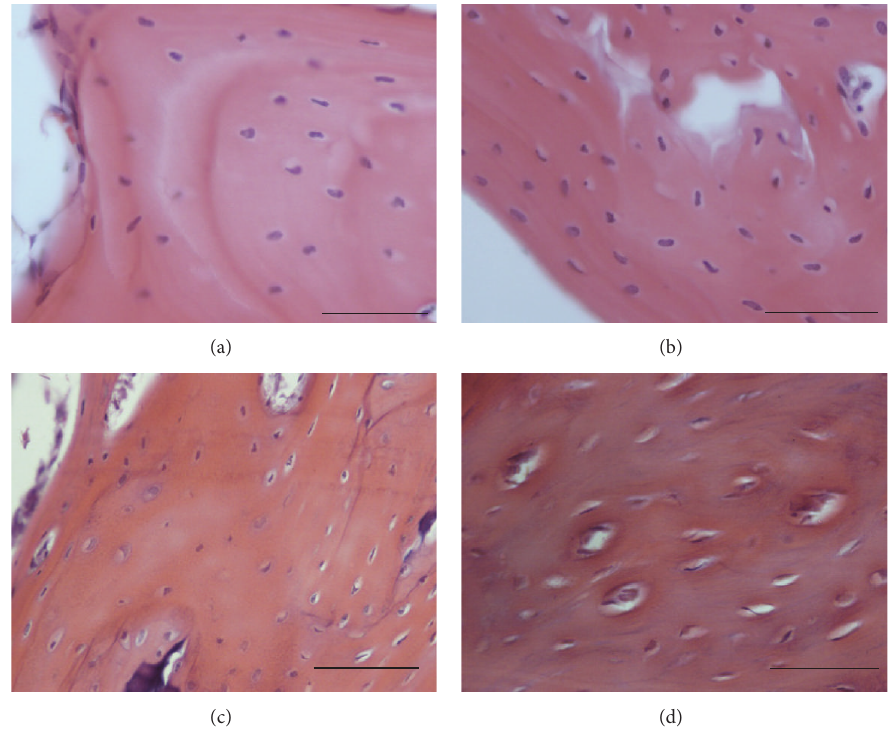
Figure 3: Enoxaparin treatment prevents necrotic changes of osteocytes. Methylprednisolone treatment induced osteonecrosis demonstrated by necrotic changes of osteocytes (c + d) in comparison to PBS treated control animals (a). Enoxaparin cotreatment leads to a decrease of necrotic changed osteocytes (b). Bar represents 50 𝜇 m.